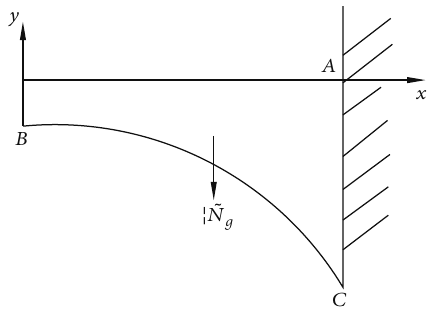
Figure 13: Mechanical analysis chart of arch beam